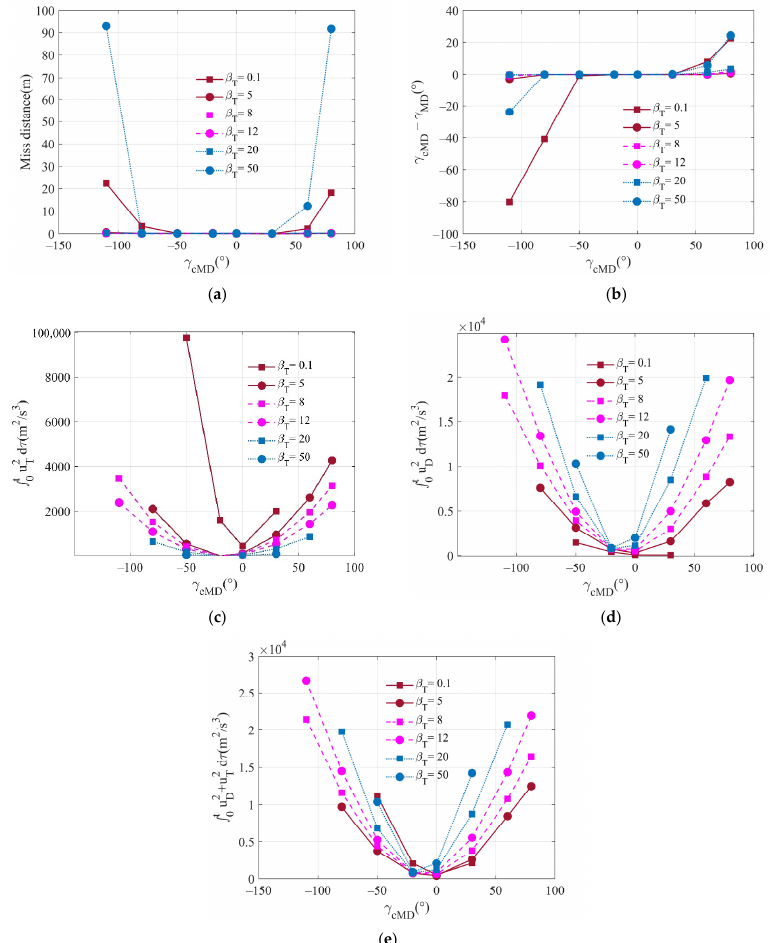
Figure 4. Comparison of performance for different β T in two-way cooperation: ( a ) miss distance for different β T ; ( b ) terminal impact angle for different β T ; ( c ) control effort of the target for different β T ; ( d ) control effort of the defender for different β T ; and ( e ) total control effort for different β T